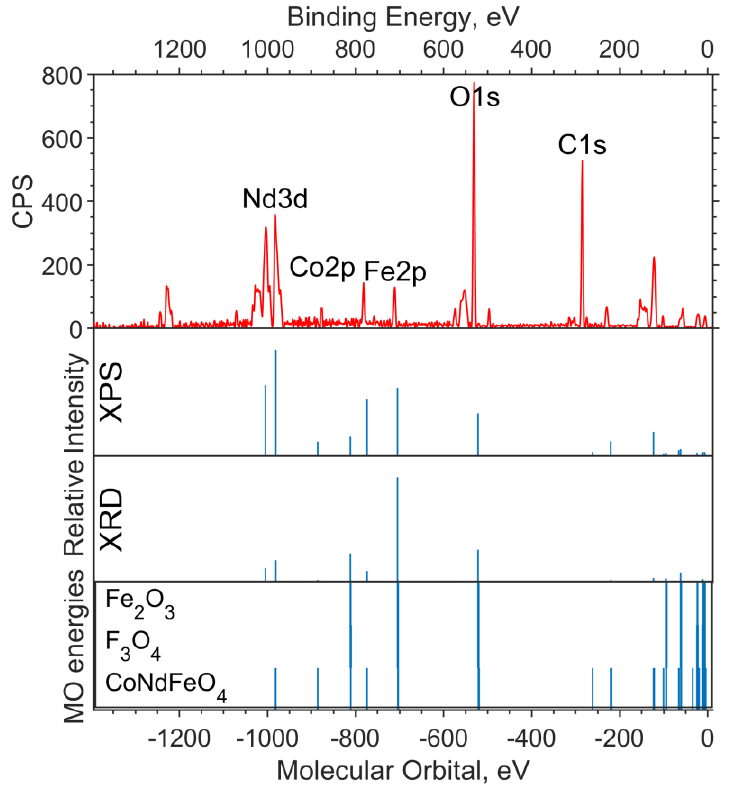
Figure 4. Survey XPS spectrum for the NdFe (1 − x) Co x B oxide powders with x = 0.05 (the background is subtracted, and smoothing is applied), the theoretical “ stick ” “ spectrum ” (intensities by the two concentrations are presented: on top — intensities based on XPS concentrations, bottom — intensities based on XRD concentrations), and the MO energies of the model compounds.